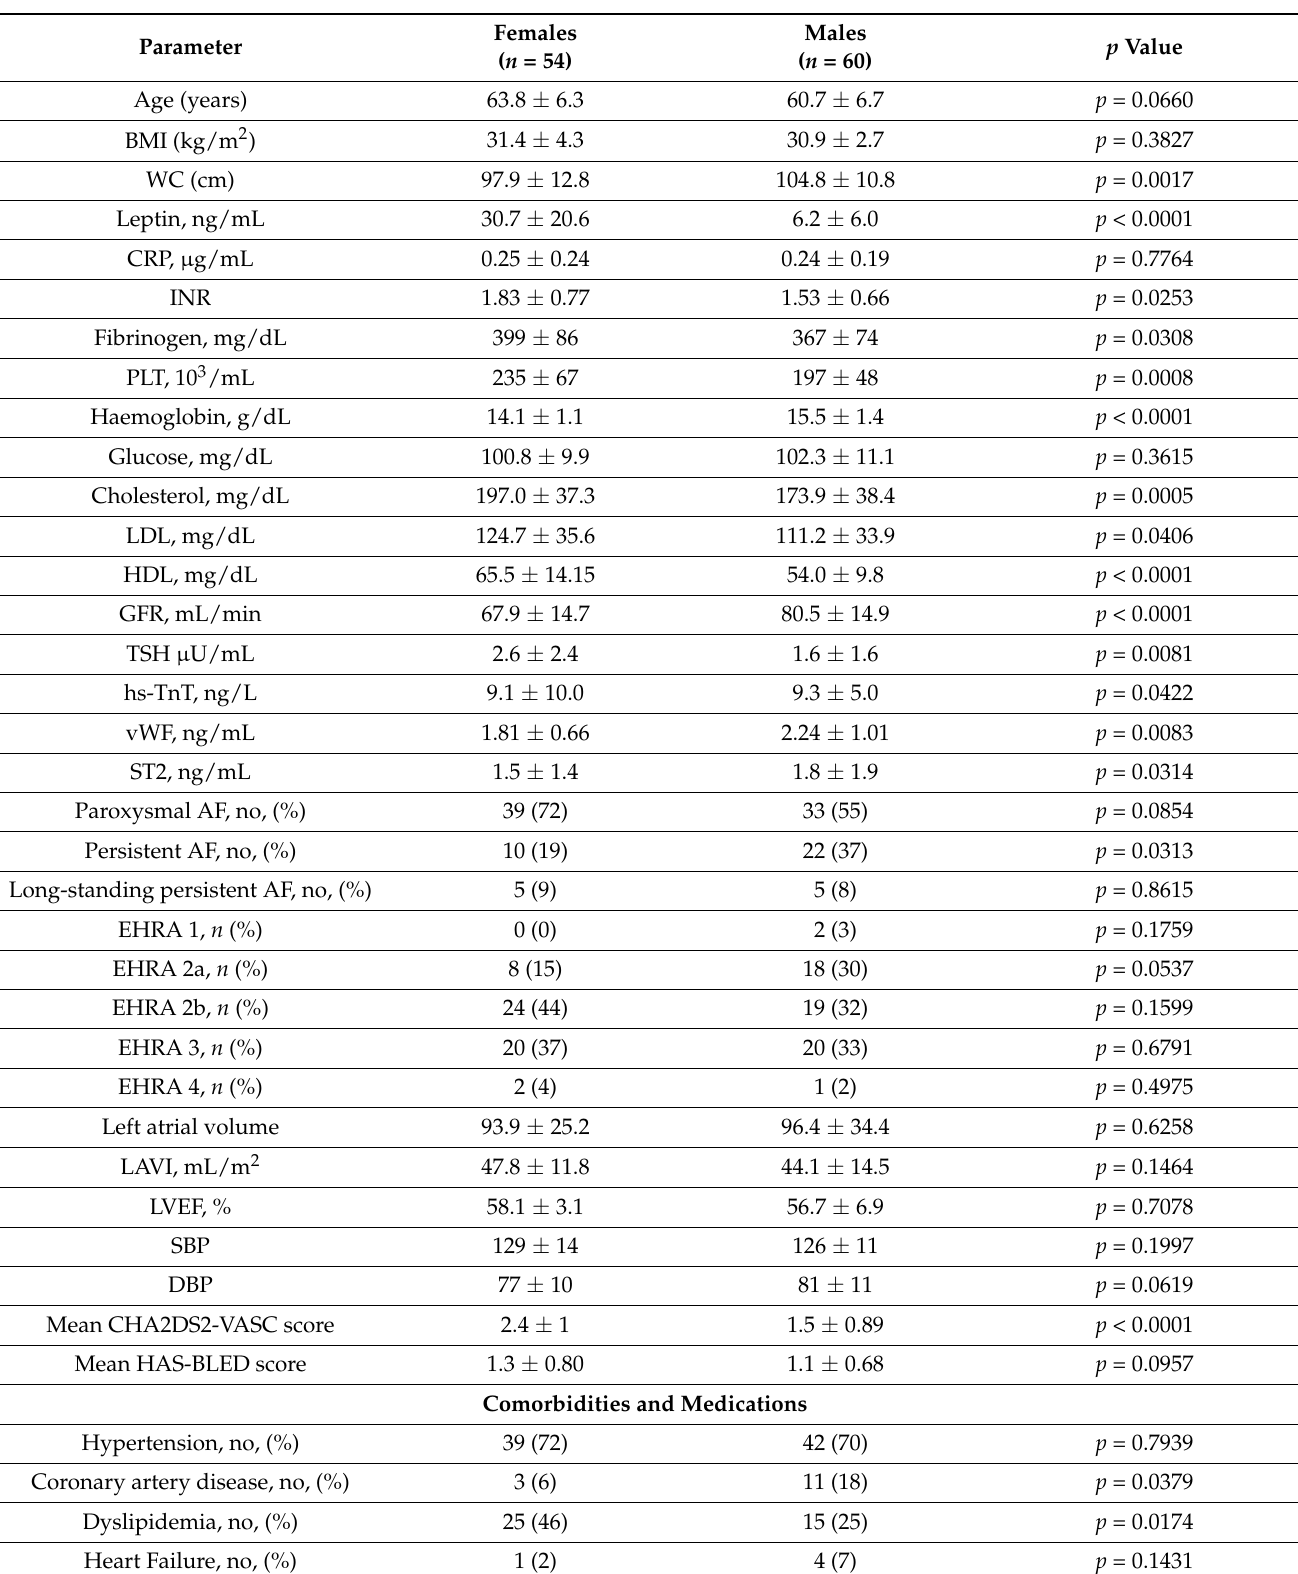
Table 1. Baseline characteristics of the studied